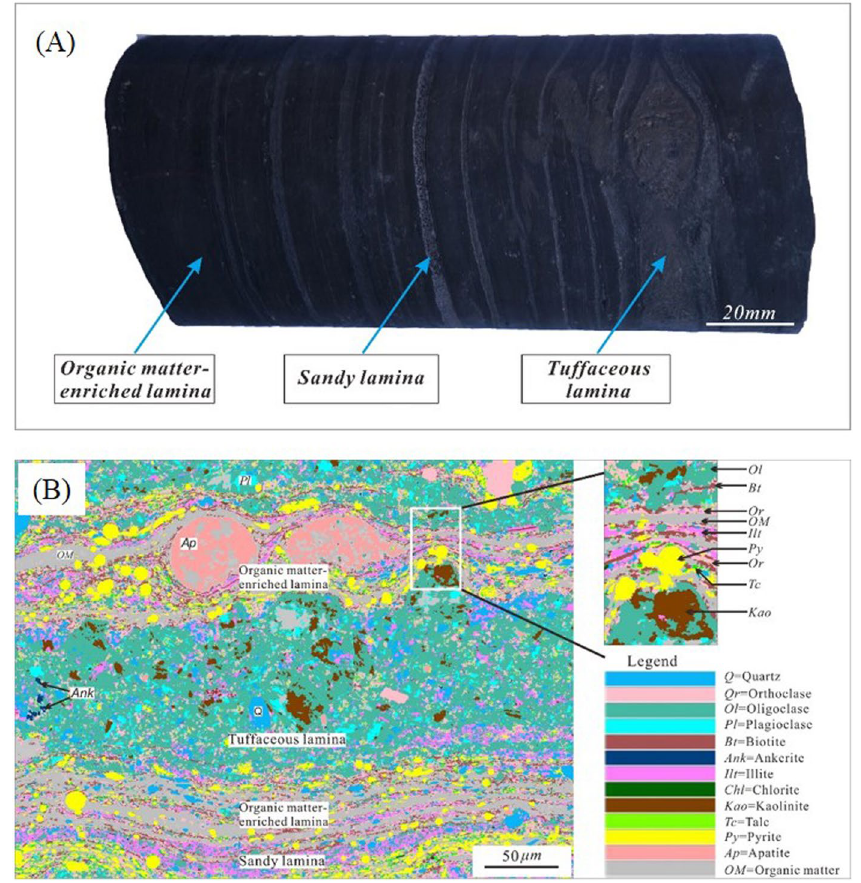
Figure 4. Laminas with different compositions of minerals. ( A ) The sandy lamina is grayish-white, the tuffaceous lamina is brown, and the organic matter-enriched lamina is black. ( B ) BSE image of mineral analysis of shale from the YK01 well. Oligoclase is dominant, followed by orthoclase, pyrite, organic matter, and quartz. The white box amplified on the right indicates that the minerals in the shale have a layered